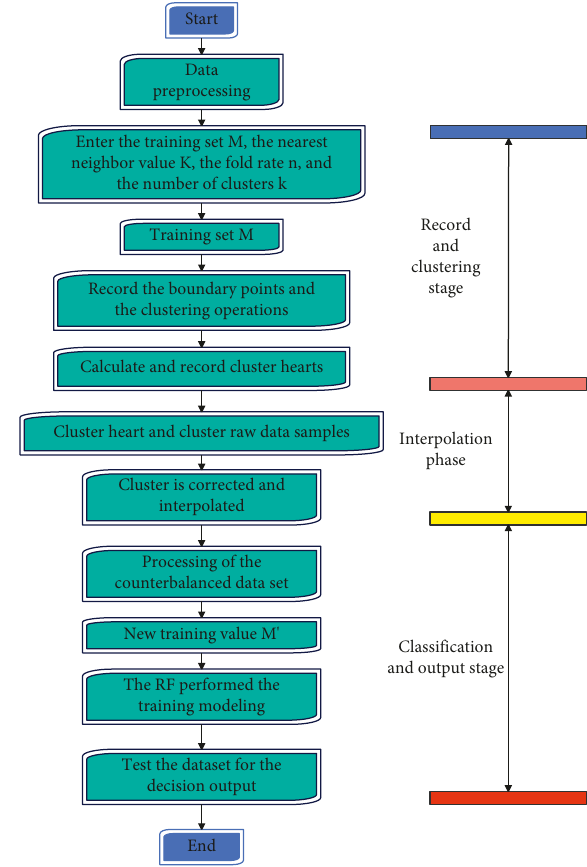
Figure 3: Flowchart of the KM-SMOTE